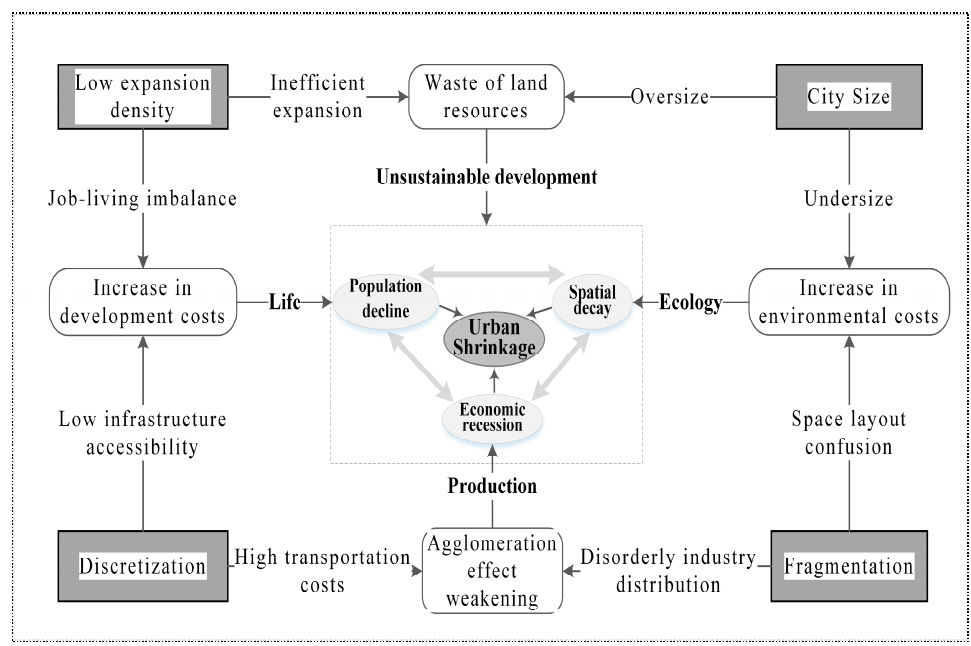
Figure 1. The theoretical mechanism behind the influence of urban form on urban shrinkage.